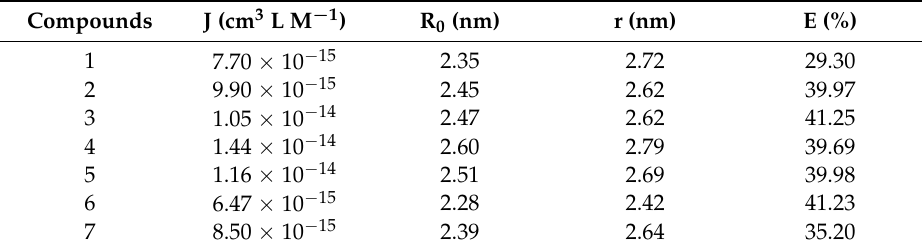
Table 4. Energy transfer parameters of the different compounds—BSA